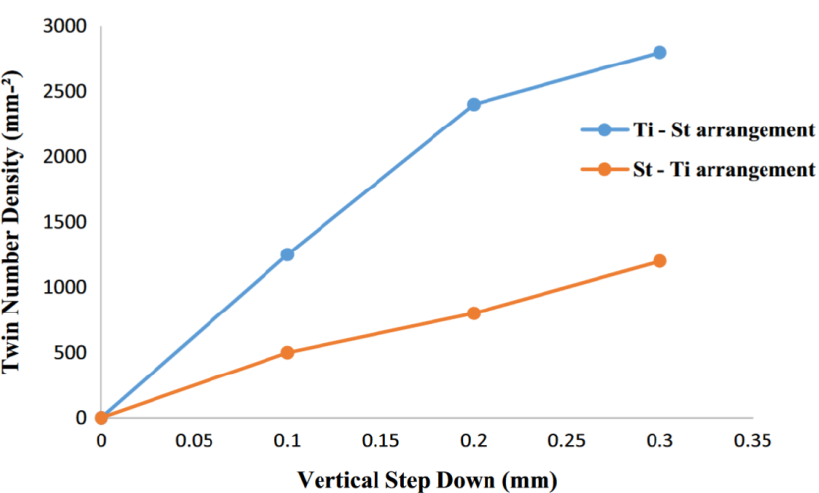
Figure 15. Evolution of twin density as a function of vertical step-down in the two arrangements (St—steel) (adapted with permission from Ref. [41], Copyright 2017 Springer-Verlag London Ltd., part of Springer Nature).